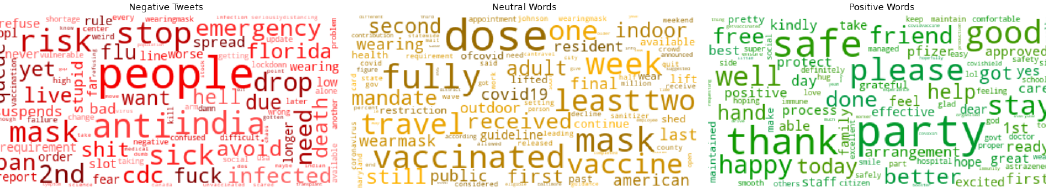
Figure 12. Top frequency word distribution for Twitter Dataset 2 on healthy lifestyle.